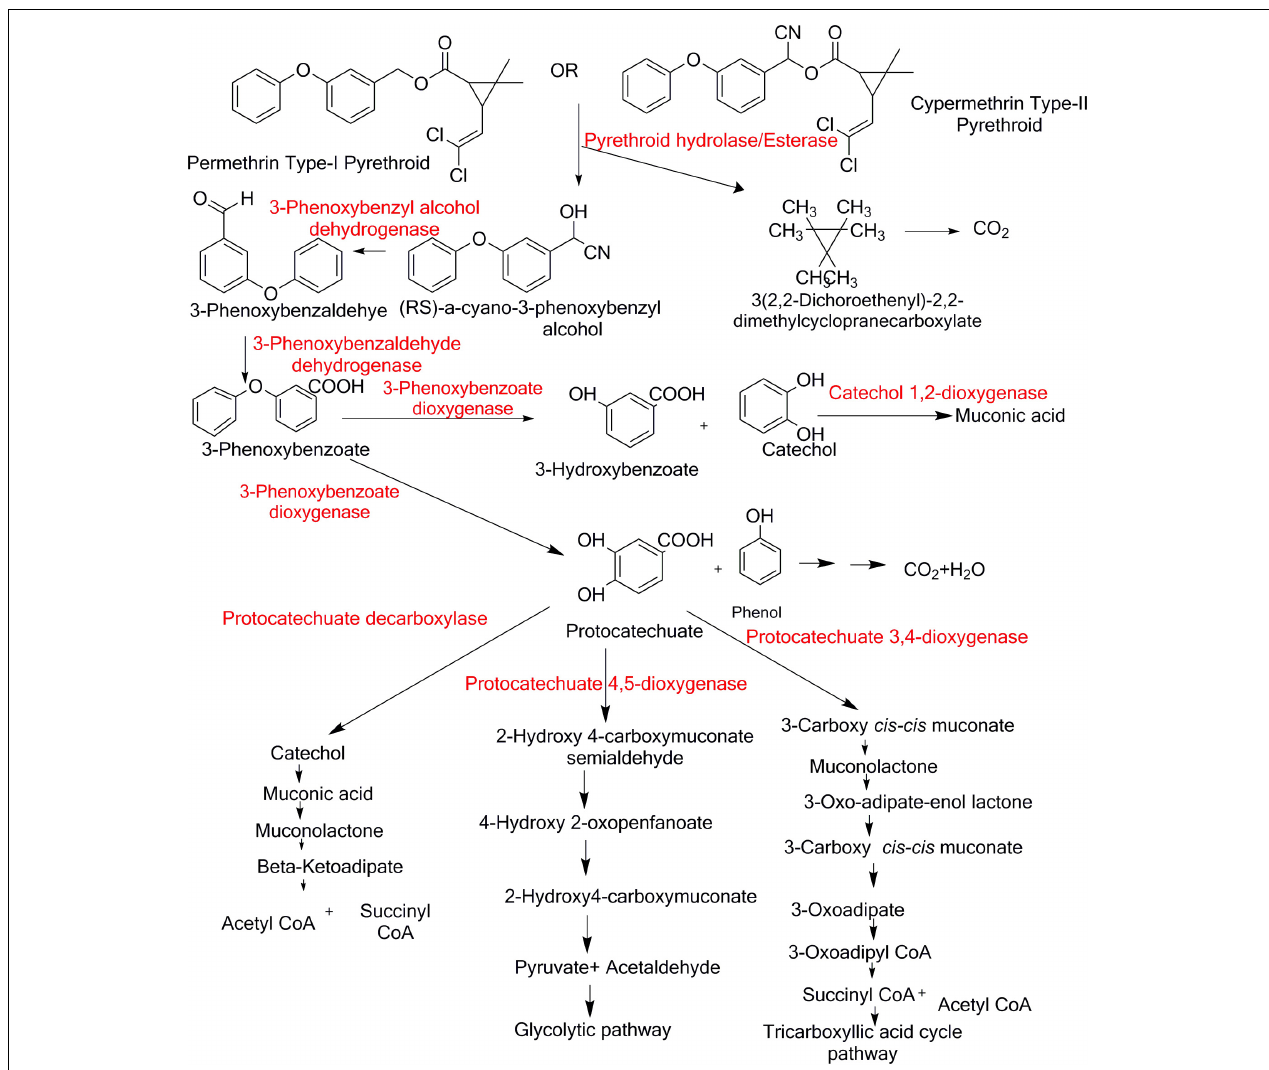
FIGURE 2 | Detailed metabolic pathways of pyrethoids in